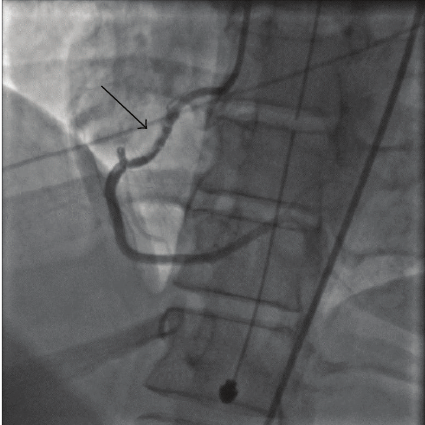
Figure 3: Emergent PCI was performed with placement of bare metal stents in proximal and mid RCA leading to restoration of the normal coronary blood flow (TIMI 3